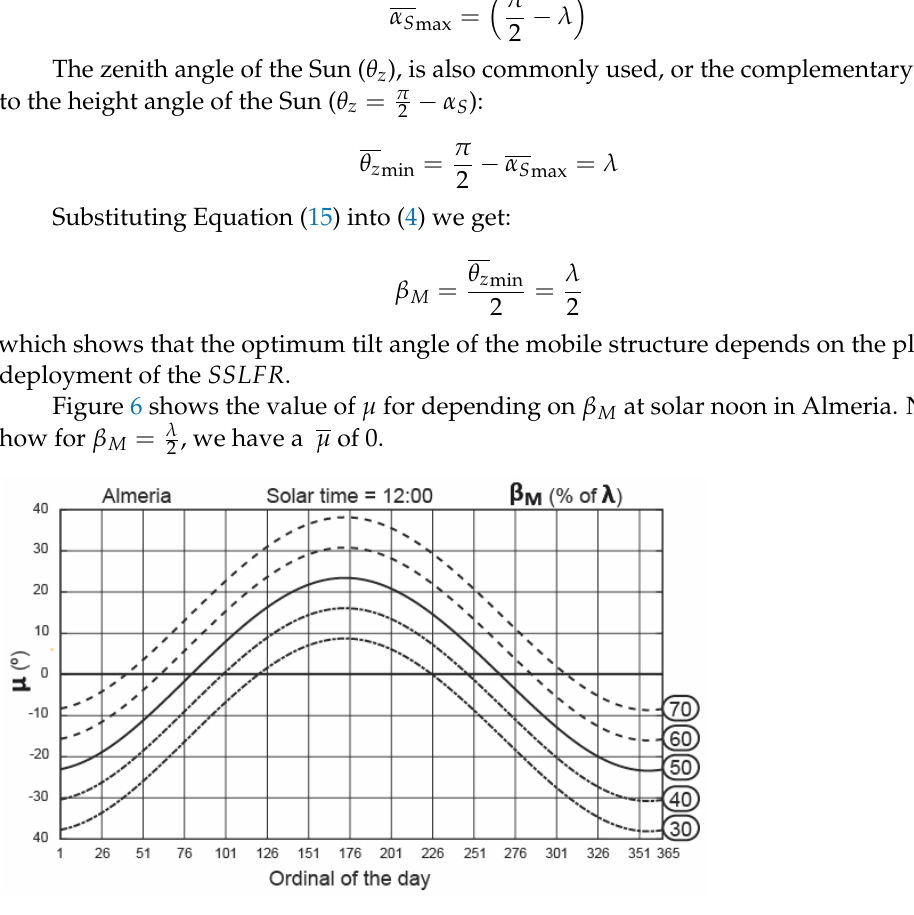
Figure 6. Value of µ for several β M